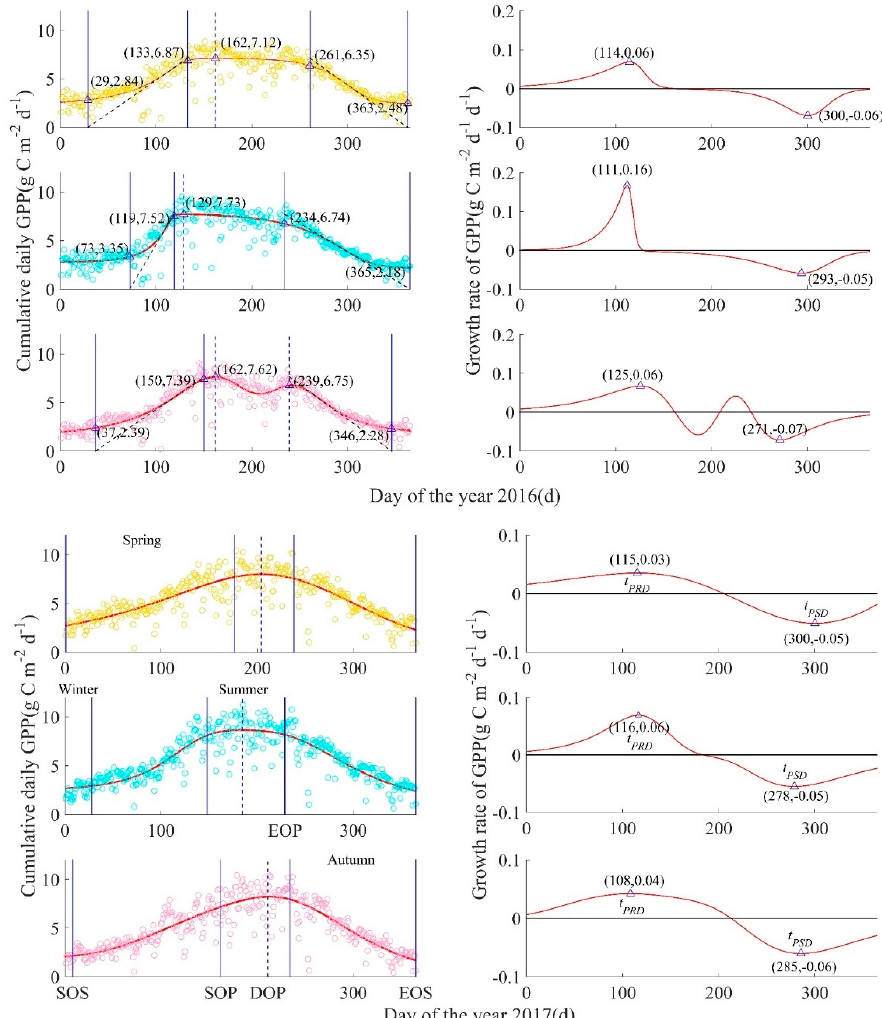
Figure A2. GPP-derived ecosystem-scale phenological process for mesic, intermediate, and xeric sites by year, from 2009 to 2017. Left column: Circles are measured cumulative daily GPP(g C m − 2 d − 1 ), with mesic in yellow (top), intermediate in turquoise (middle), and xeric in pink (bottom), solid curves are fitted plant growth functions A ( t ), four solid blue lines from left to right are SOS (start of growing season), SOP (start of peak), EOP (end of peak), EOS (end of growing season), and the blue dotted line is at the date of the modeled maximum daily GPP (DOP = day of peak). Right column: Red curves represent the GPP growth rate function for each corresponding site, and triangles represent the peaks of the GPP growth rate function, such that t PRD is the peak recovery date, the maximum recovery point of GPP, and t PSD is the peak senescence date, the maximum senescence point of GPP; the date when the GPP growth rate equals zero was the date of the peak of modeled cumulative daily GPP. Table A1. Description of ecosystem-scale phenology of the mesic, intermediate, and xeric sites.